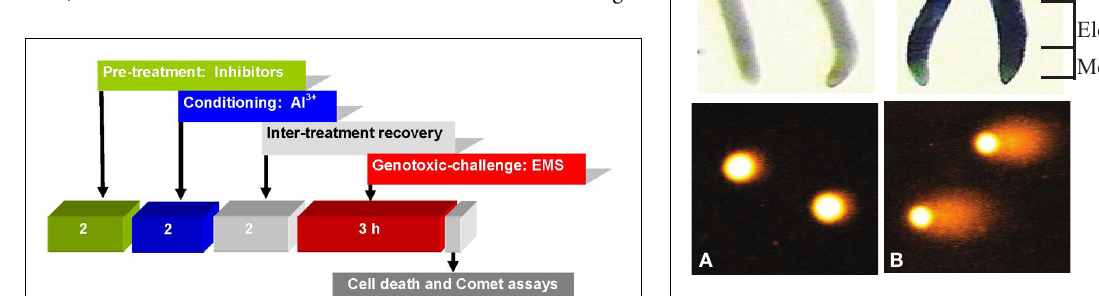
FIGURE 2 | Treatment protocol showing time and sequence of pre-treatment, conditioning, challenging treatments, cell death, and Comet assays in root cells of A. cepa .